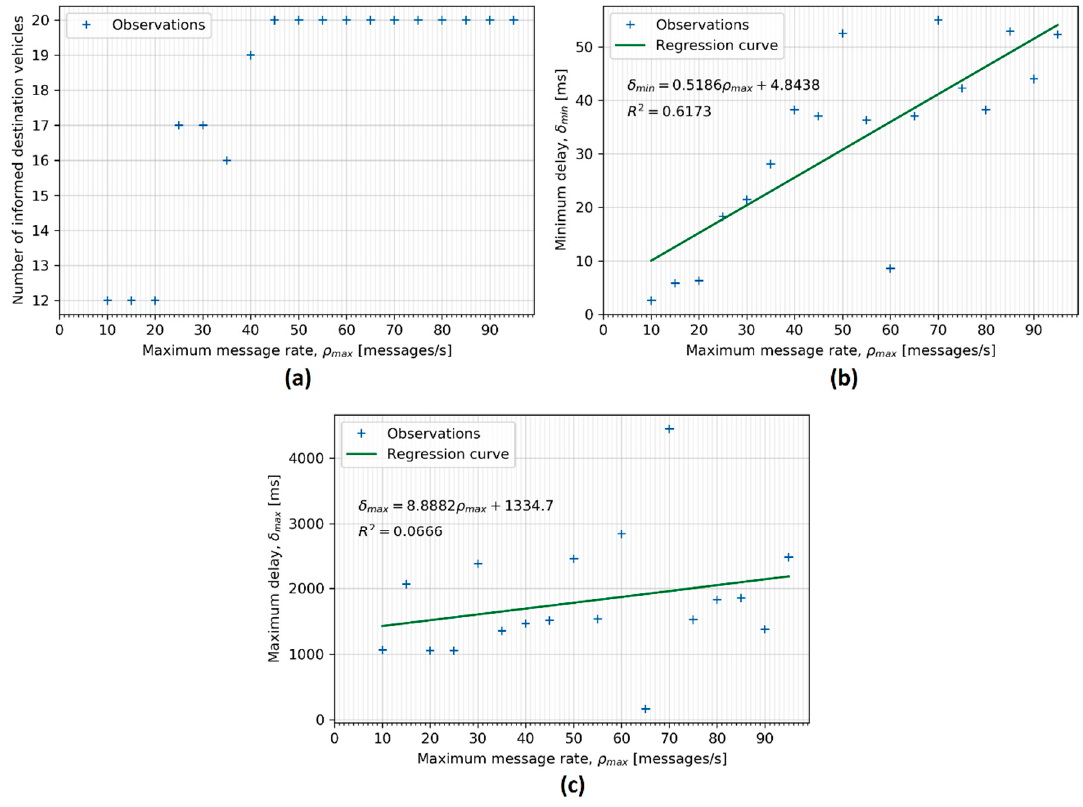
Figure 6. ( a ) The number of informed destination vehicles as a function of the maximum message rate, 𝜌 (cid:3040)(cid:3028)(cid:3051) . ( b ) The minimum end-to-end delay as a function of the maximum message rate, 𝜌 (cid:3040)(cid:3028)(cid:3051) . ( c ) The maximum end-to-end delay as a function of the maximum message rate, 𝜌 (cid:3040)(cid:3028)(cid:3051) . All panels were obtained by simulating the Žilina scenario. To facilitate the identification of the overall trend in panels ( b , c ), we show the line obtained by the ordinary least squares regression method. By increasing the value 𝜌 (cid:3040)(cid:3028)(cid:3051) , the number of vehicles that the EV can communicate to increases